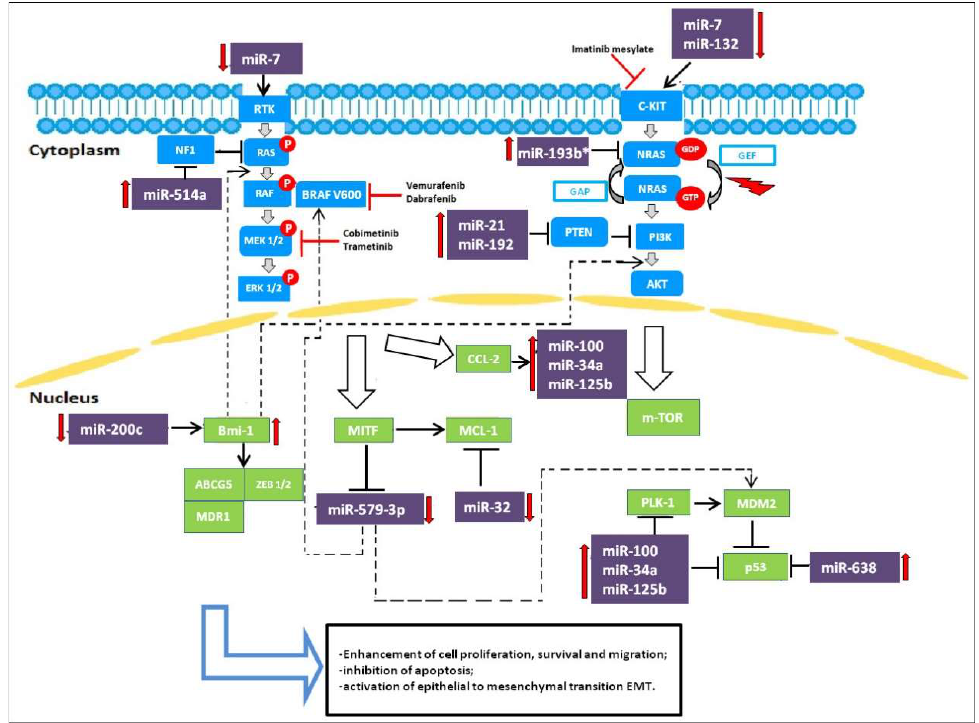
Figure 1. miRNAs involved as oncogenes and oncosuppressors targeting MAPK and PI3K/AKT pathways in melanoma resistant cells to BRAFi.